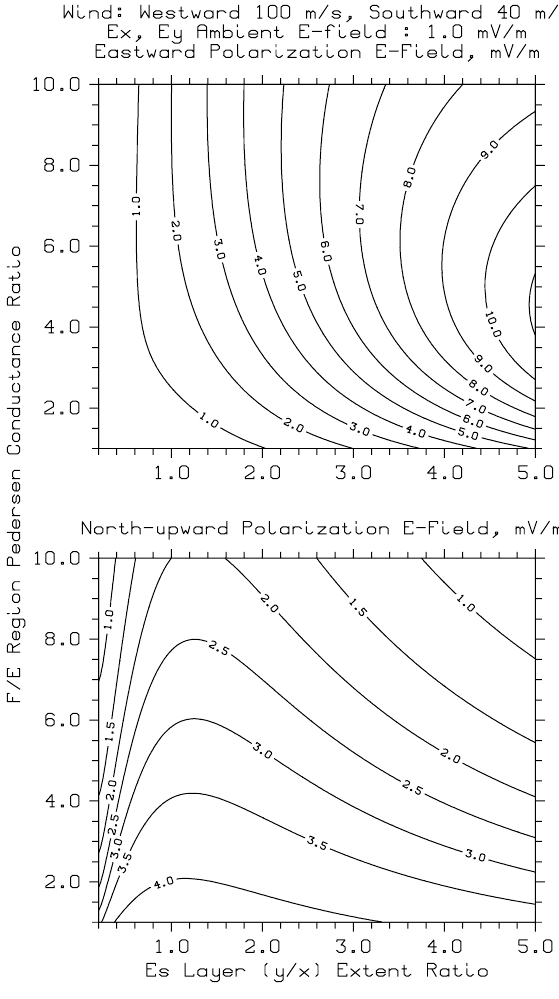
Fig. 3. Same as Fig. 2 but for the case of a strong southward wind component (100m/s) that is larger than the westward wind compo- nent (50m/s). In this case, the situation reverses relative to the one in Fig. 2 and we can have large meridional polarization fields if the patch is relatively elongated in the zonal